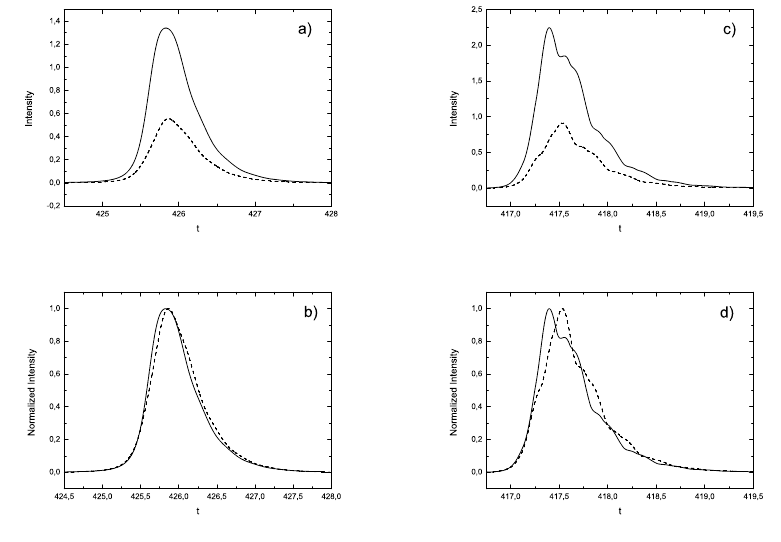
Figure 5. Shapes of forward (+) and backward (-) traveling pulses inside the resonator before the outgoing mirrors using passive (a, b) and active (c, d) Q-switching. Using TWM we can expect that for outgoing pulses through the front